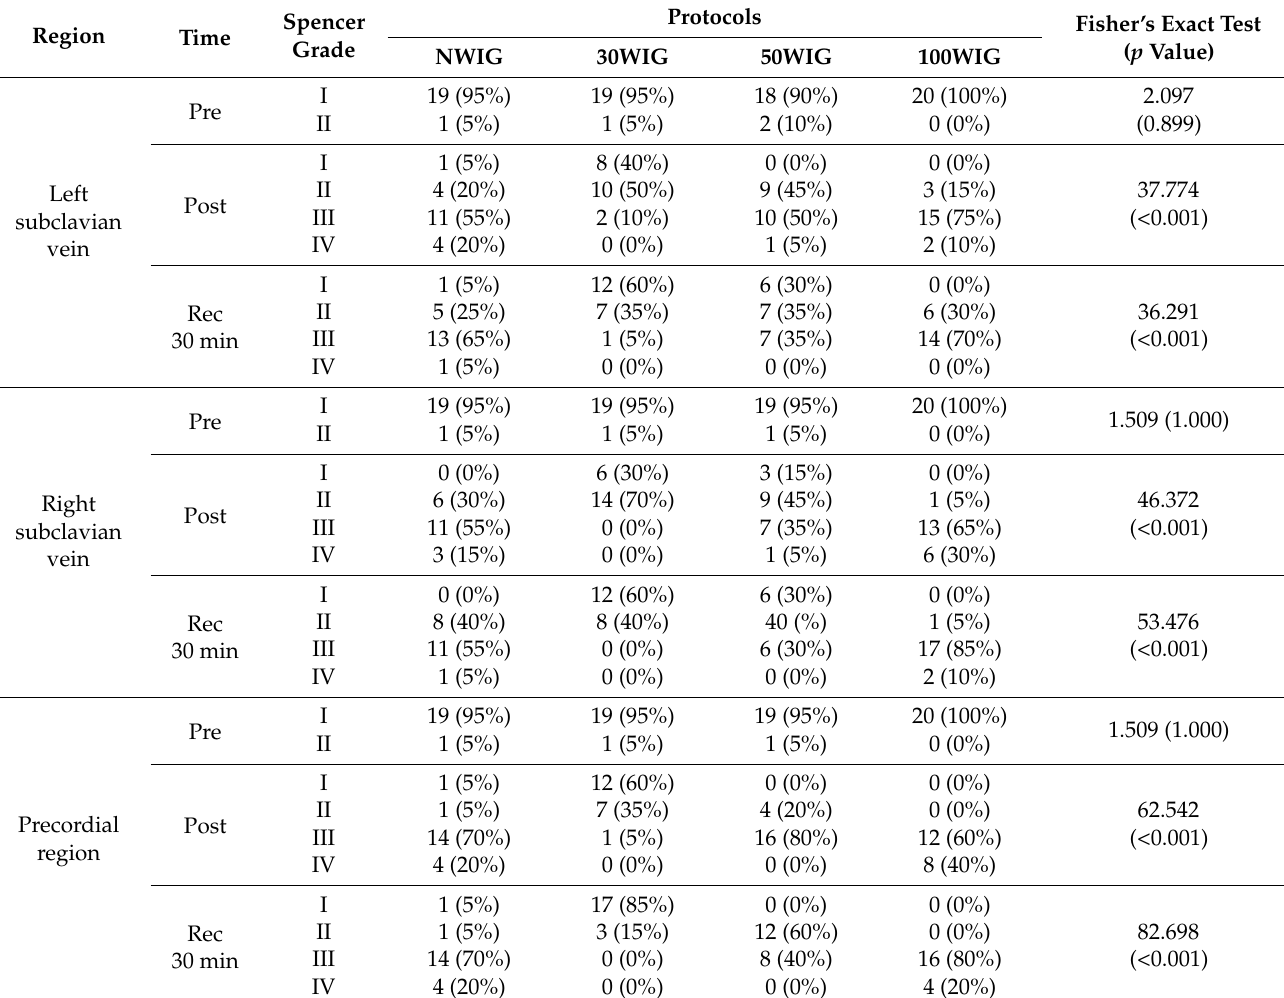
Table 7. Frequency of participants according to Spencer grade of bubble in the left and right subclavian veins and precordial